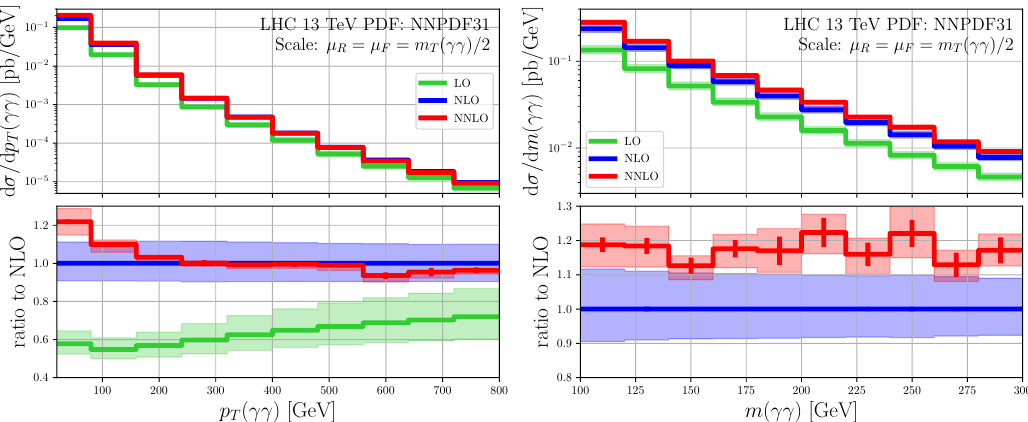
Figure 1 . Absolute p T ( γγ ) (left) and m ( γγ ) (right) differential distributions. Shown are the pre- dictions in LO (green), NLO (blue), NNLO (red) QCD. The colored bands around the central scales are from 7-point scale variation. The colored bars shows the estimated Monte Carlo integration error in each bin. The lower panel shows the same distributions but relative to the NLO central scale prediction.